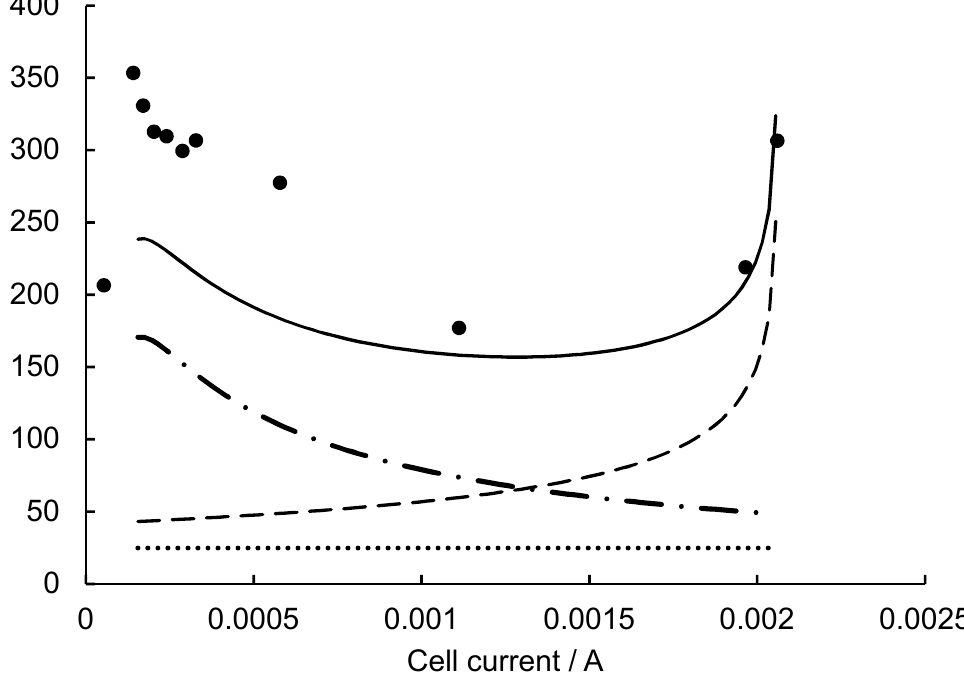
Figure 6. Variation of SMFC resistances at pH 2: experimental R i ( • ) and the predictions of R i (solid line), R act (dashed dotted line), R conc (dashed line) and R ohmic (dotted line).